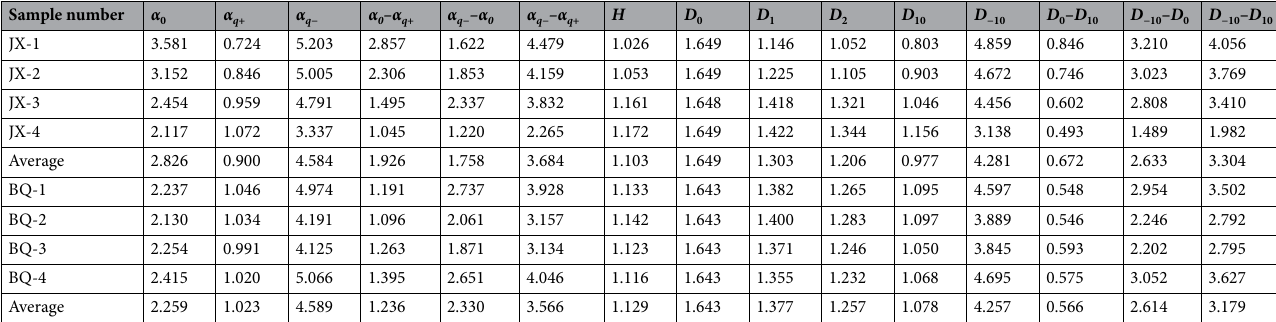
Table 4. The calculated parameters of the multifractal singular spectrum and the generalized fractal dimension